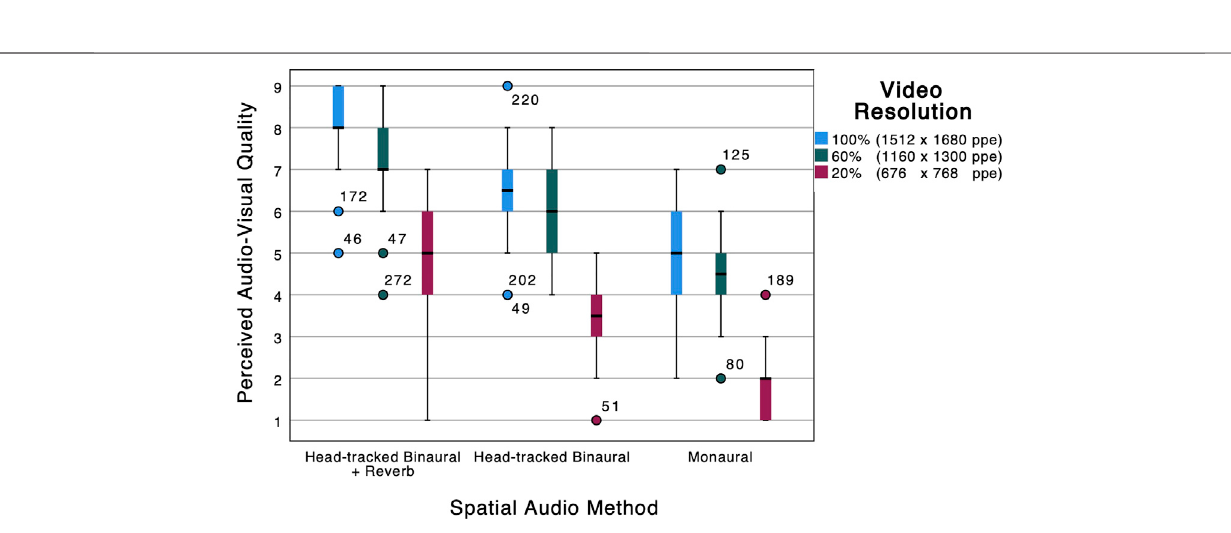
Frontiers in Signal Processing |